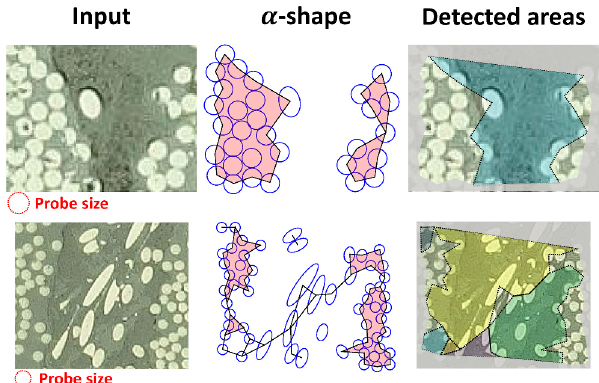
Fig. 23 Experimental results on two real-world microscope images. Separate fiber-deficient areas are distinguished by different colors; gray areas are boundary